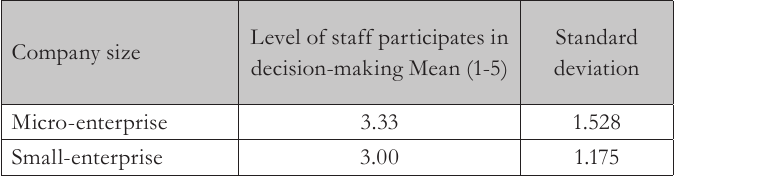
Tab. 3 - The level of staff participates in decision-making. Source: own compilation